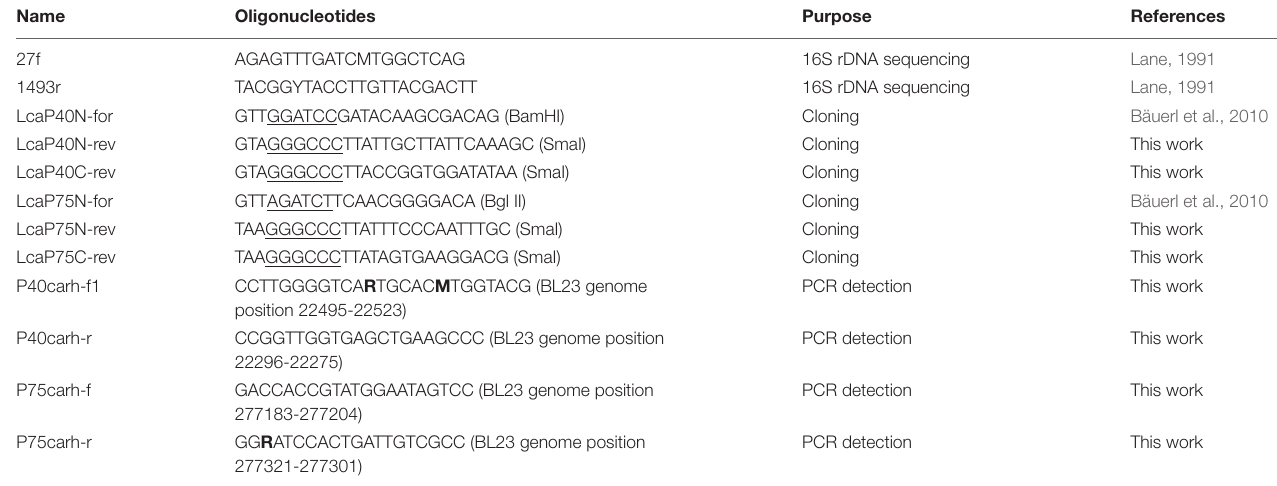
TABLE 2 | List of Oligonucleotides used in this study and their